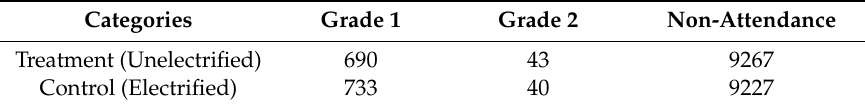
Table 7. Grade distribution at age 5.